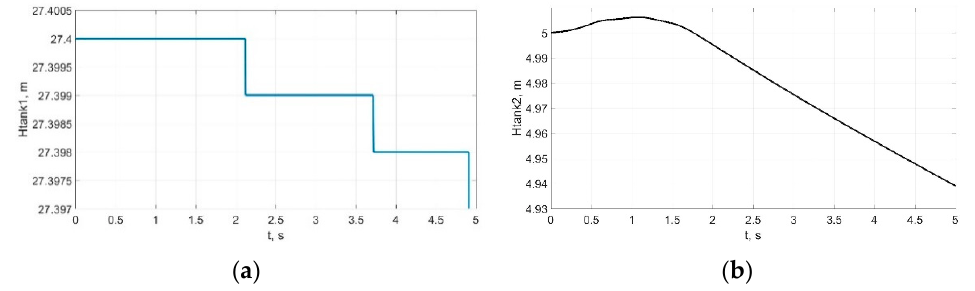
Figure 10. LNG level observation from the beginning to the end of solution time: ( a ) in the LNG tank; ( b ) in the Suction Drum. Figure 11 indicates the results of simulated pressure in the second pipeline (L2).